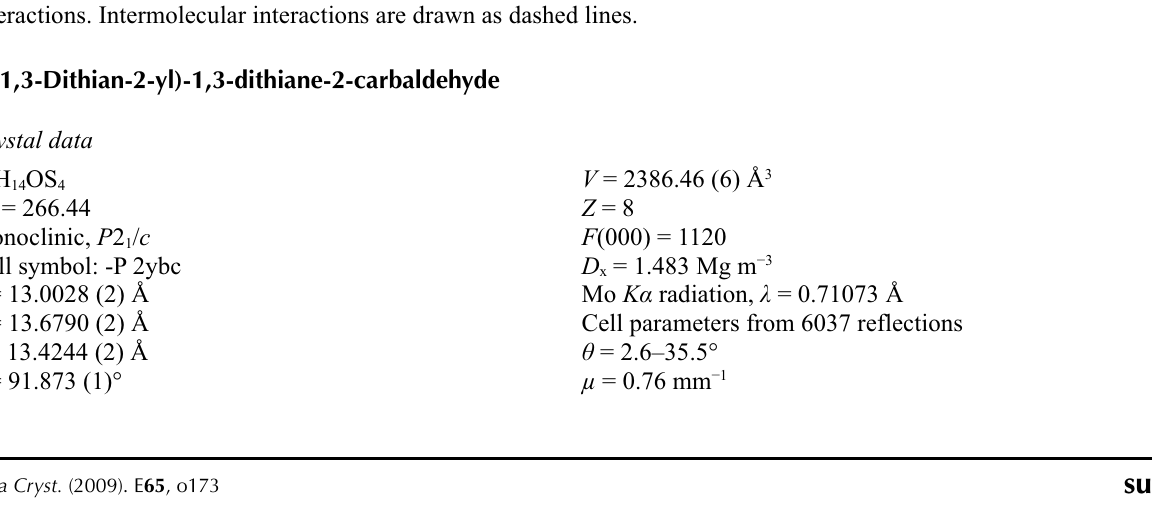
The crystal packing for (I), viewed down the b axis showing linking of molecules through C—H···O and C—H···S interactions. Intermolecular interactions are drawn as dashed